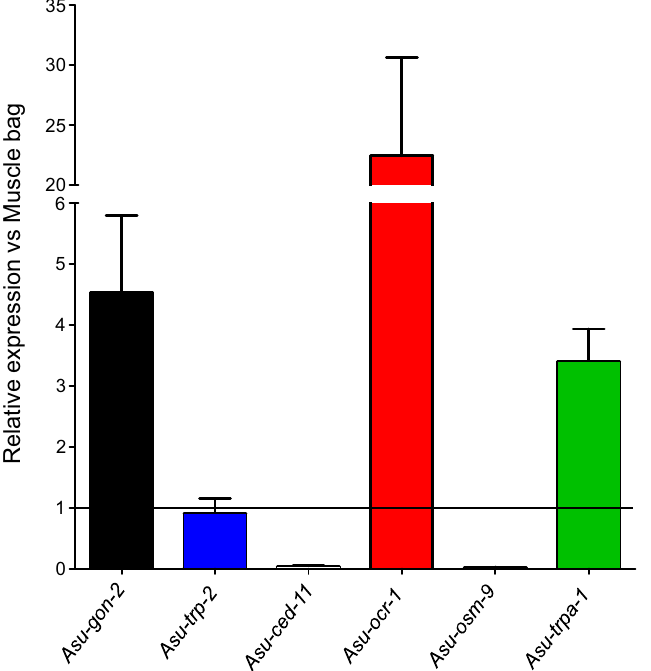
Figure 3. Differential expression of TRP channels between intestine and muscle bag. Bar charts (expressed as mean ± SEM) demonstrating transcript level analysis for TRP channels from intestinal samples for GON-2 (black bar), TRP-2 (blue bar), CED-11 (small), OCR-1 (red bar), OSM-9 (small) and TRPA-1 (green bar) when compared to paired muscle samples. n = 15 individual worms over three biological